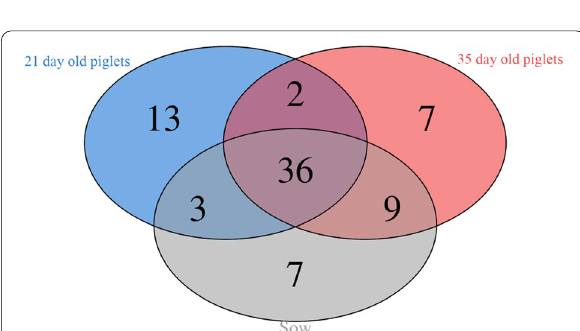
Fig. 2 Venn diagram of core microbiota at the genus level between sows and piglets at 21 and 35 days of